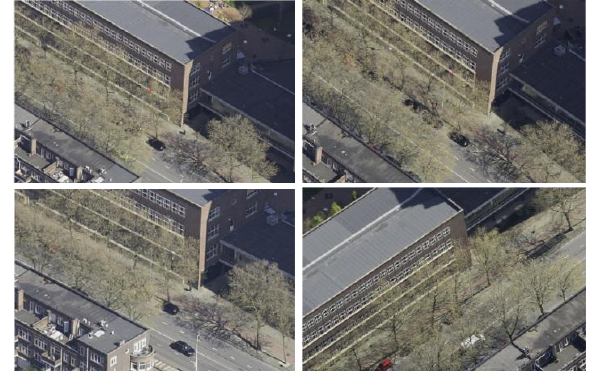
Figure 15. Façade is occluded due to